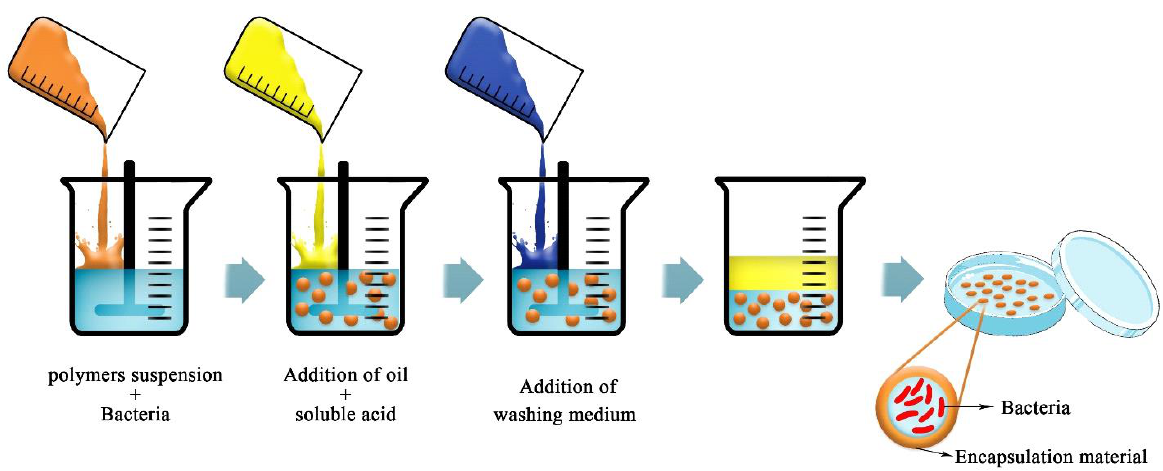
Figure 5. Schematic picture of the emulsification technique for bacterial encapsulation (adapted from